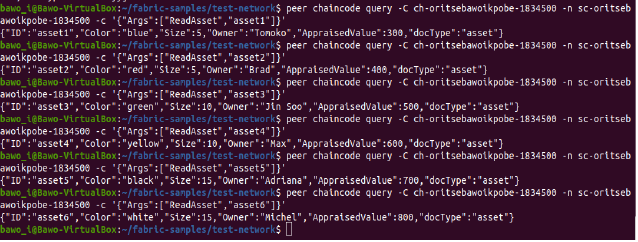
Figure 10: Basic query per user